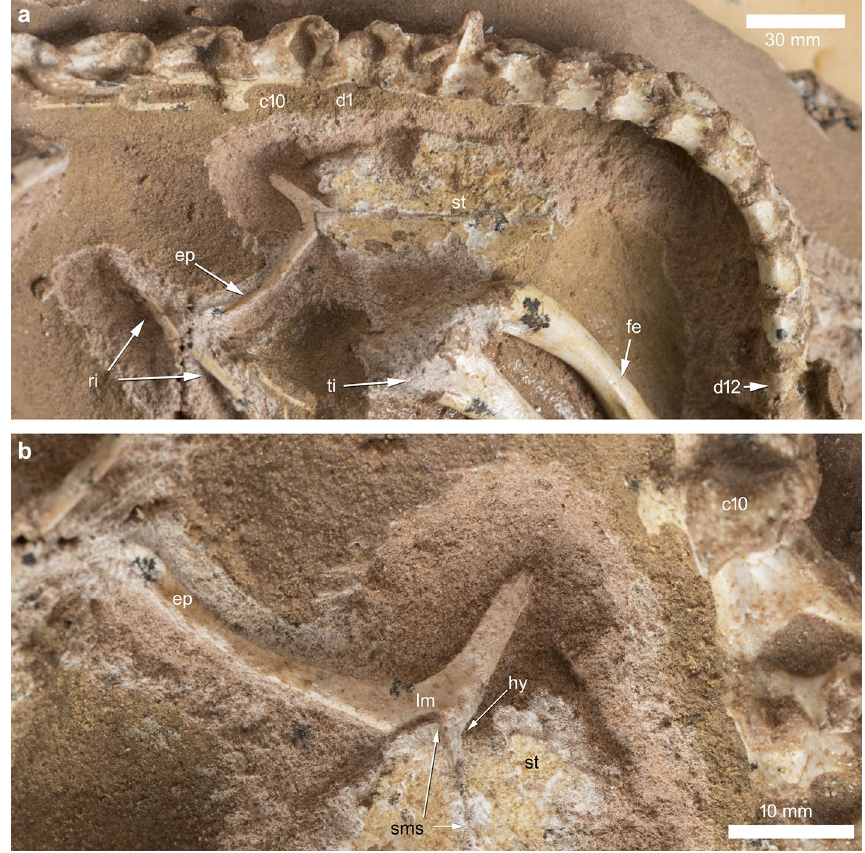
Figure 3. Mechanically prepared pectoral region of Halszkaraptor escuilliei MPC D-102/109. ( a ) Exposed sternum and furcula in visceral view. ( b ) Detail of the sternal articular surface of the furcula in left laterovisceral view. c10 10th cervical vertebra, d1 1st dorsal vertebra, d12 12th dorsal vertebra, ep epicleideum, fe femur, hy hypocleideum, lm lipped margin of the sternal facet, ri ribs, sms open midline suture between the sternal plates, st sternal plate, ti tibia. Scale bar: 30 mm ( a ), 10 mm ( b ). Photos by T.